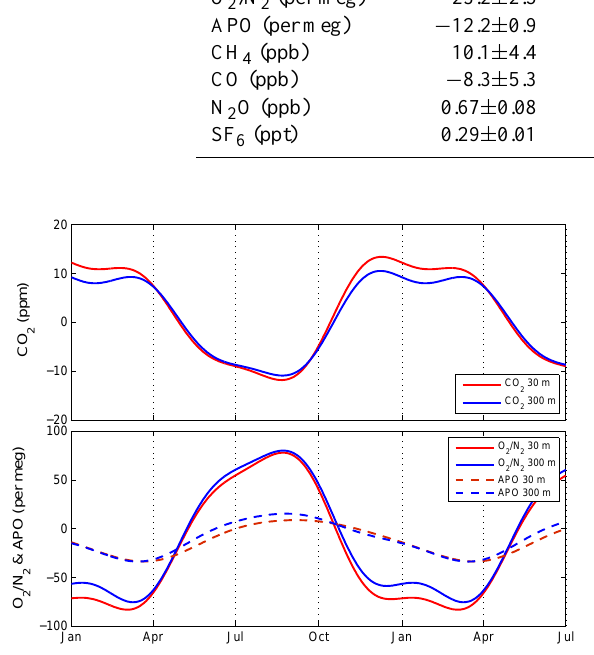
Fig. 6. Seasonal cycles of CO 2 , O 2 /N 2 and APO, at two sampling